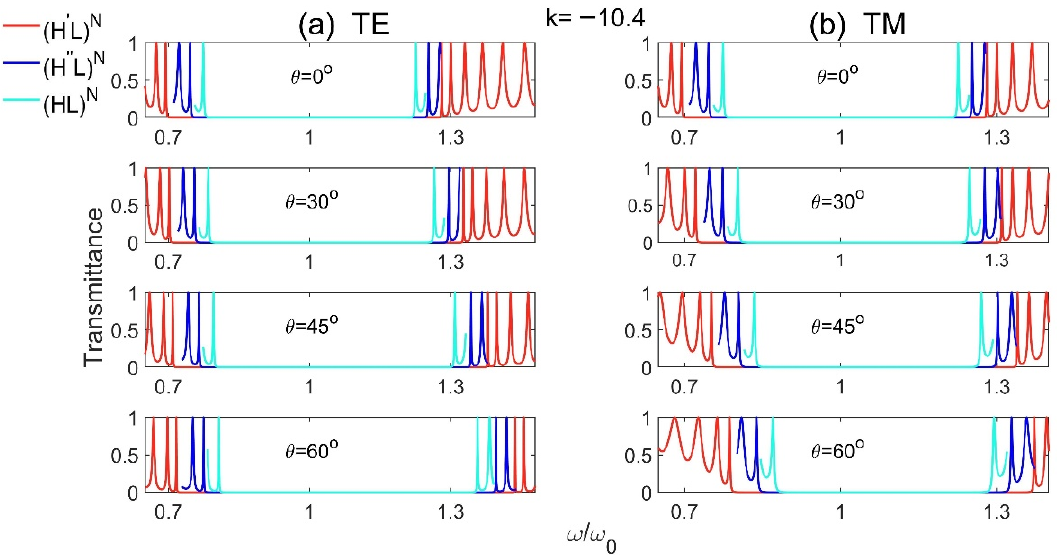
Figure 2. The transmission spectra of Model 1 ( H (cid:48) L ) N , Model 2 ( H (cid:48)(cid:48) L ) N and the reference model ( HL ) N for different incident angles at slope k = − 10.4 of the gradient materials for ( a ) TE and ( b ) TM polarizations.